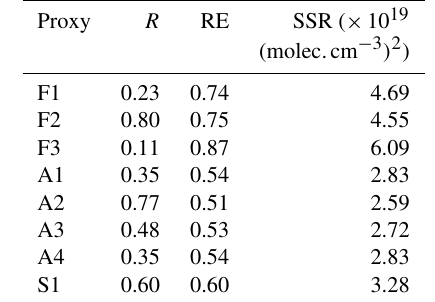
Table 4. The ability of the newly developed proxies to predict [H 2 SO 4 ] measured during the ETNA 13 flight. For each proxy, R is the correlation coefficient (Pearson) between predicted and ob- served [H 2 SO 4 ], RE is the relative error and SSR is the sum of squared residuals. Note that based on corresponding p values, all correlations were found to be significant ( p <